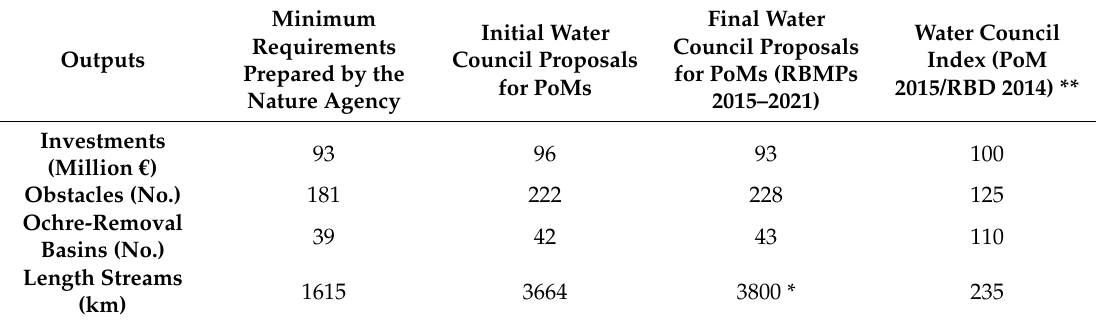
Table 2. Overview of the water council outputs, showing the differences between the minimum requirements formulated by the Nature Agency (non-participatory process) and the reported proposals for Programmes of Measures (PoMs) described in the draft River Basin Management Plans (RBMPs) from the water councils and in the final RBMPs, 2015–2021 (participatory